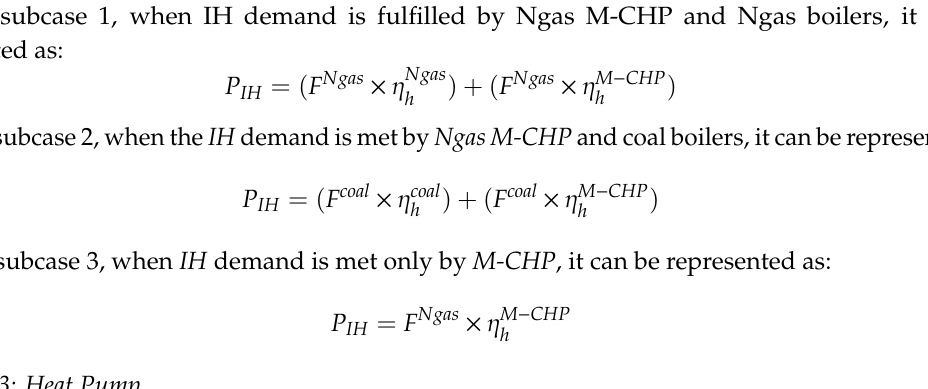
Figure 9. Coal, Ngas and Ngas micro CHP are used to meet individual heating demand.